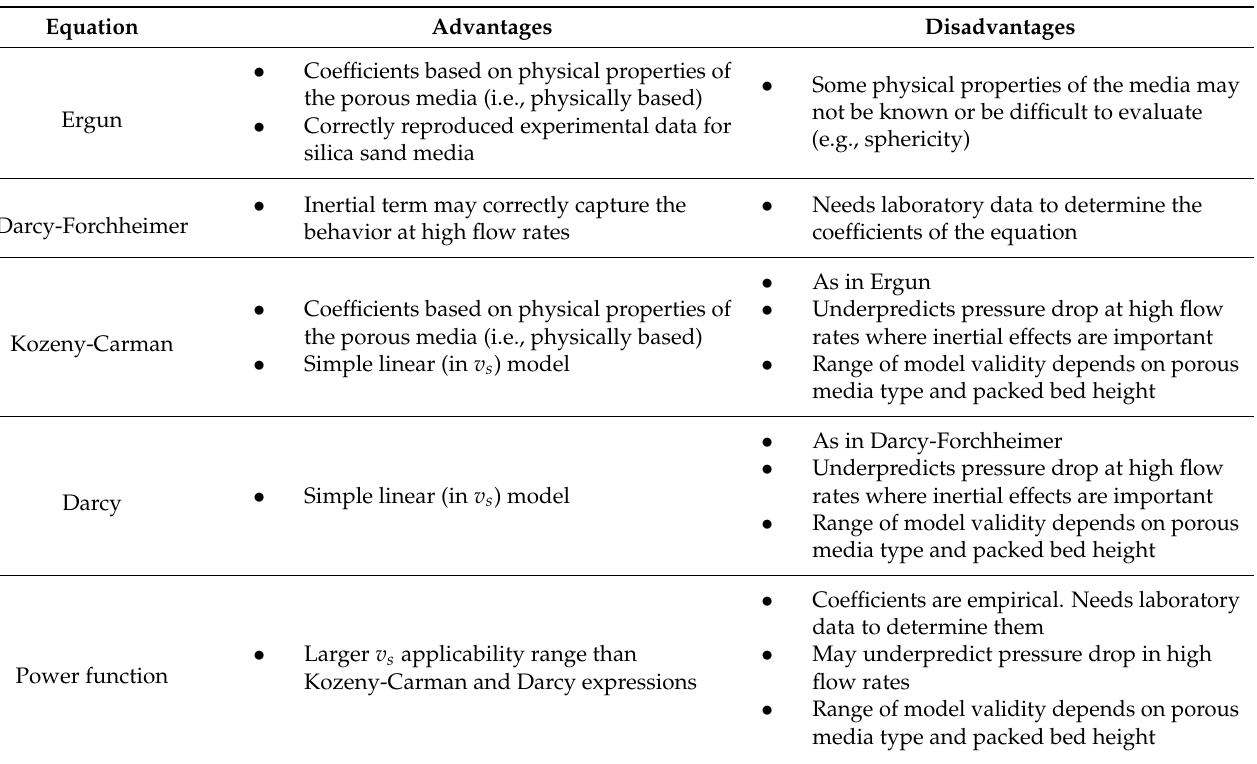
Table 6. Main advantages and disadvantages of the momentum sink equations analyzed in the present study. Equation Advantages Disadvantages